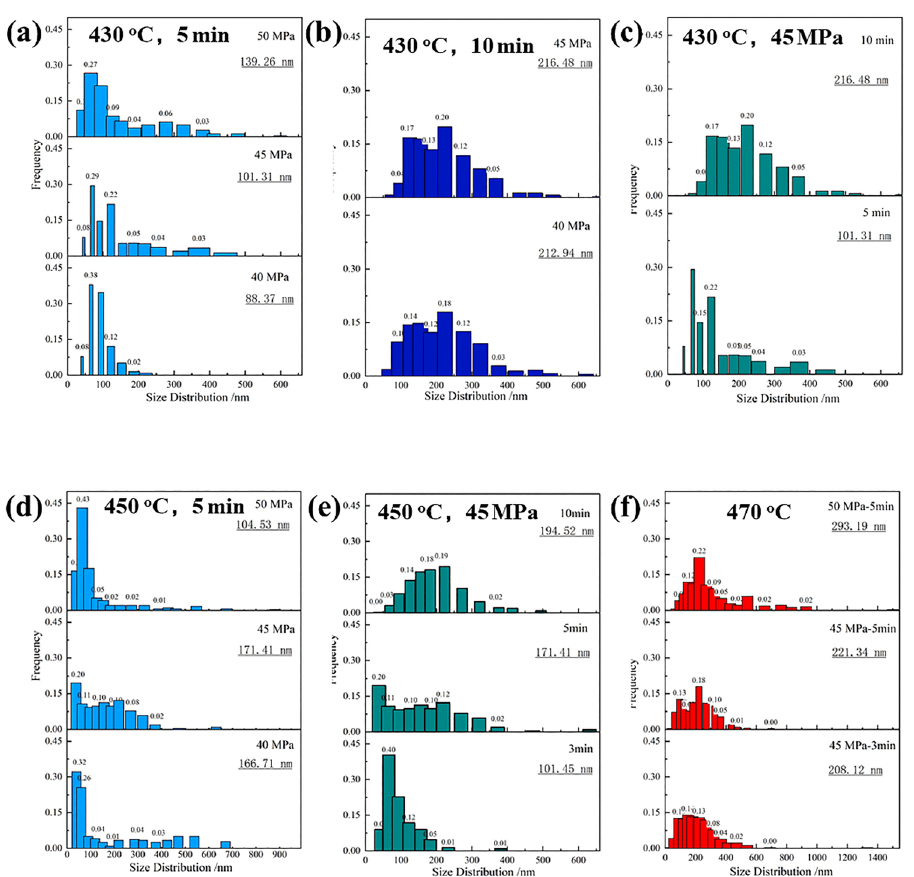
Figure 6. Size-distribution of β 1 phase particle at various sintering conditions: ( a–c) at 430 °C; ( d , e) at 450 °C; ( f) at 470 °C, the mean size was inserted in the corresponding figure.